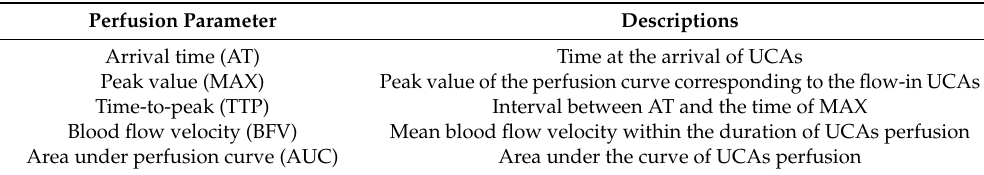
Table 2. Perfusion parameters derived from the perfusion curve.